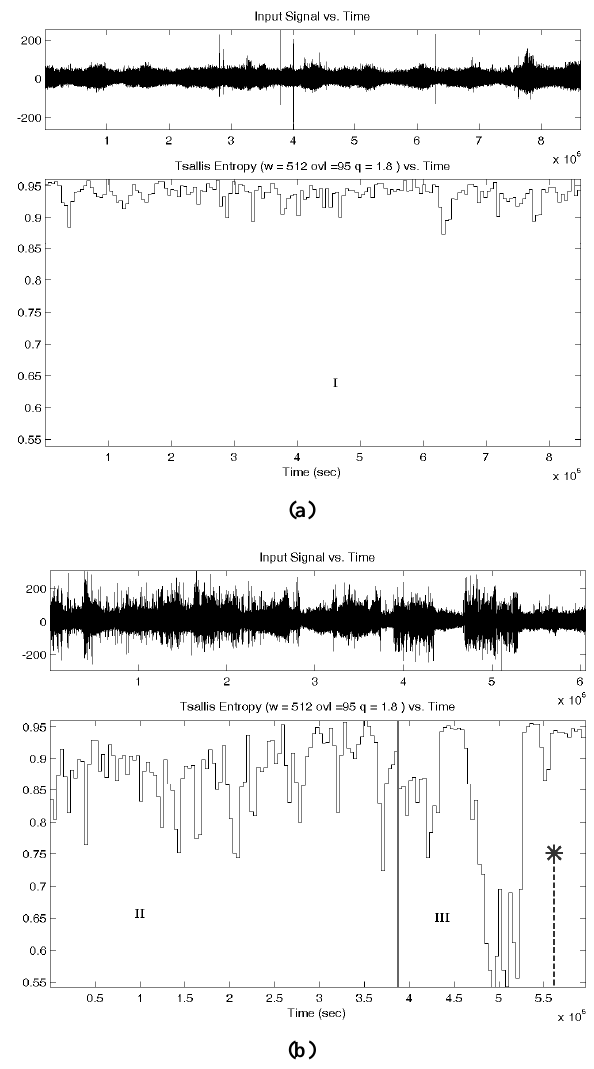
Fig. 5. Tsallis entropy evolution with time (a) for epoch I, and (b) for the epochs II and III of the signal of Fig. 2. The analyzed signal is given on top of the resulted Tsallis entropy temporal evolution, time aligned for direct reference. We observe a gradual increase of the organization of the underlying process as the EQ is approaching.